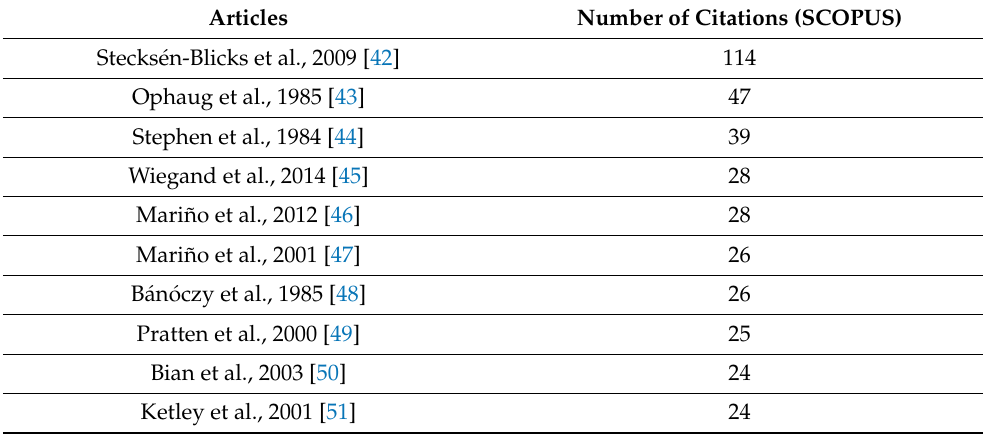
Table 6. Top ten original research articles on milk fluoridation, and total citations.